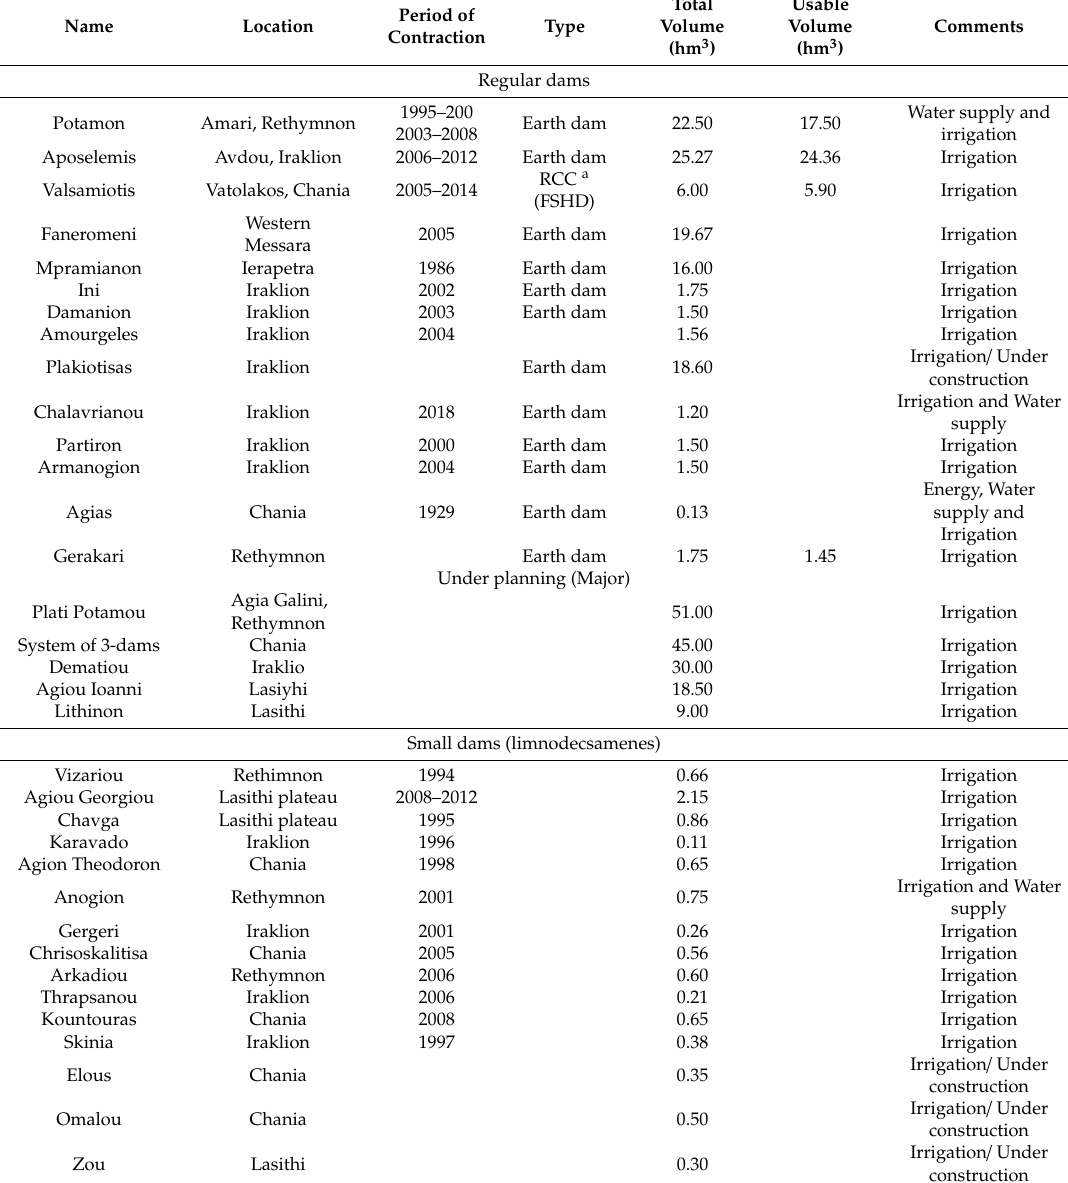
Table 7. Major dams in Crete. Source: